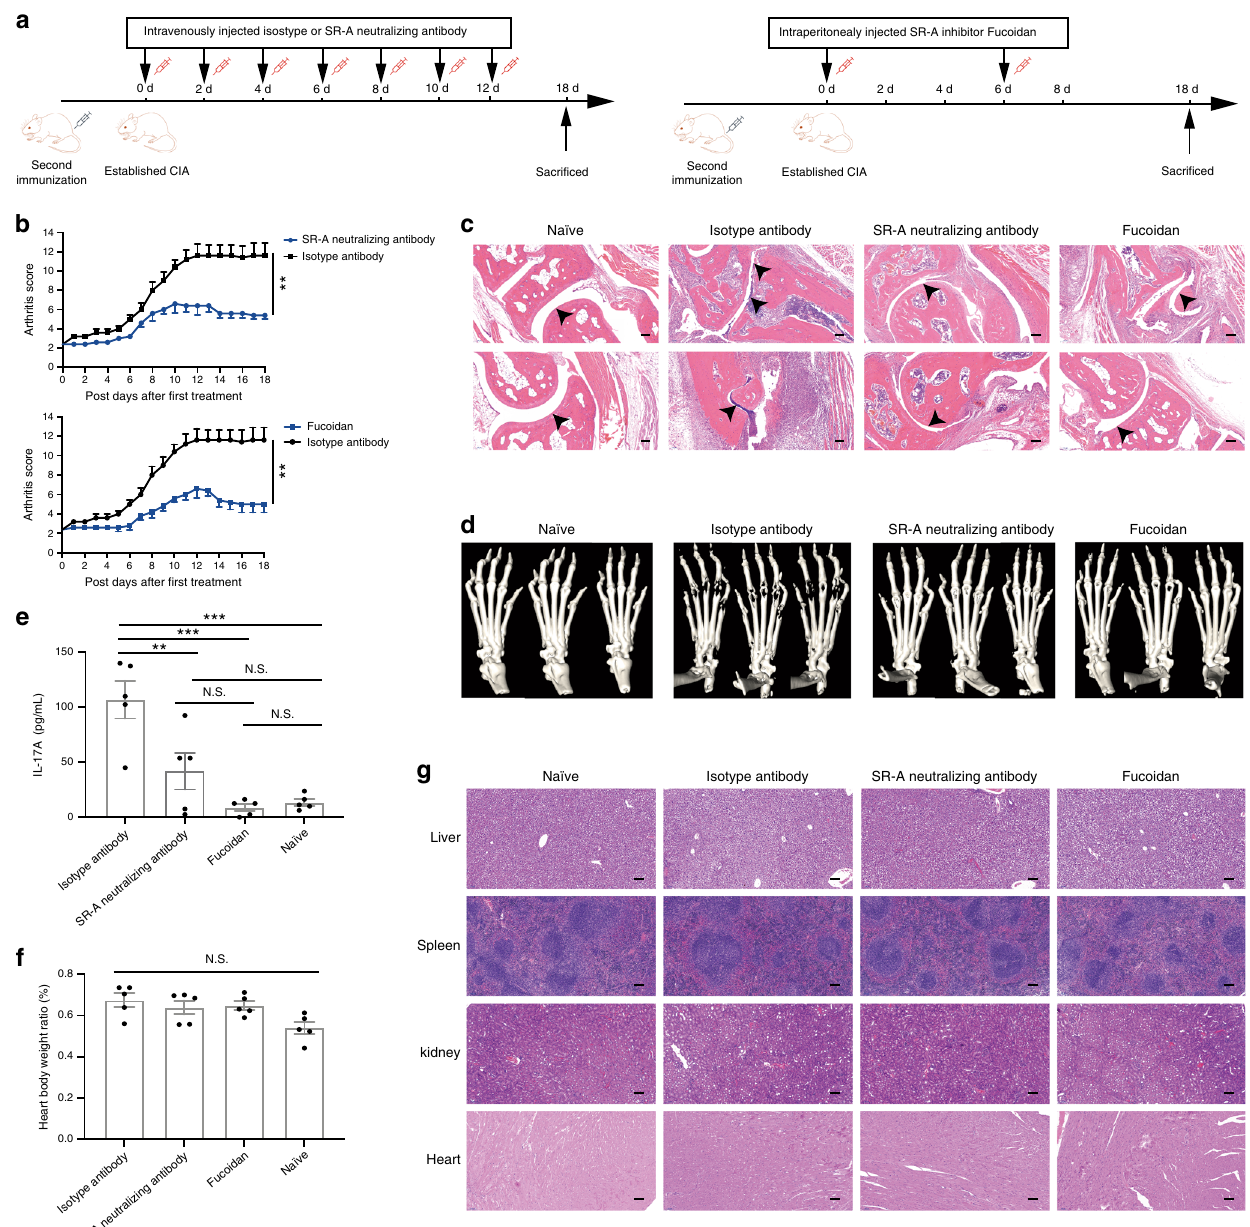
Fig. 8 Inhibition of SR-A ameliorates severity of arthritis in mice. a Scheme of the experimental setup. Intervention was initiated when the arthritis scores were averagely over 2. CIA mice were intravenously injected with SR-A neutralizing antibody or isotype IgG (2 μ g/mouse) once every 2 days for seven doses, or were intraperitoneally injected with SR-A inhibitor Fucoidan (100 μ g/mouse) on day 0 and day 6 after initiation for two doses. b The arthritis scores in each intervention group were recorded daily after the fi rst treatment ( n = 5 per group, ** p = 0.0028 (top) and 0.0016 (bottom), respectively). c H&E staining of the sagittal sections of paws from the isotype antibody-, SR-A neutralizing antibody-, or Fucoidan-treated CIA mice and naïve mice. Arrows indicate the stenosis of articular cavity and destruction of cartilage. Scale bar = 100 μ m. d Micro-CT image showing the bone destruction of paws from the isotype antibody-, SR-A neutralizing antibody-, or Fucoidan-treated CIA mice and naïve mice. e The serum IL-17A levels were detected in the isotype antibody-, SR-A neutralizing antibody-, or Fucoidan-treated CIA mice and naïve mice ( n = 5 per group, ** p = 0.0081, *** p = 1.7201E − 04 (left) and 2.9233E − 04 (right)). f The heart body weight ratio was shown to re fl ect the heart functions ( n = 5 per group). g H&E staining of the sagittal sections of liver, spleen, kidney, and heart were performed to evaluate the organ damage. Scale bar = 100 μ m. Data are presented as mean ± SEM. Results are representative of three independent experiments. ** p < 0.01, *** p < 0.001, NS, not signi fi cant (two-way repeated measures ANOVA test b or One-way ANOVA test followed by Tukey ’ s posttest for multiple comparisons e , f ). Source data are provided as a Source Data fi